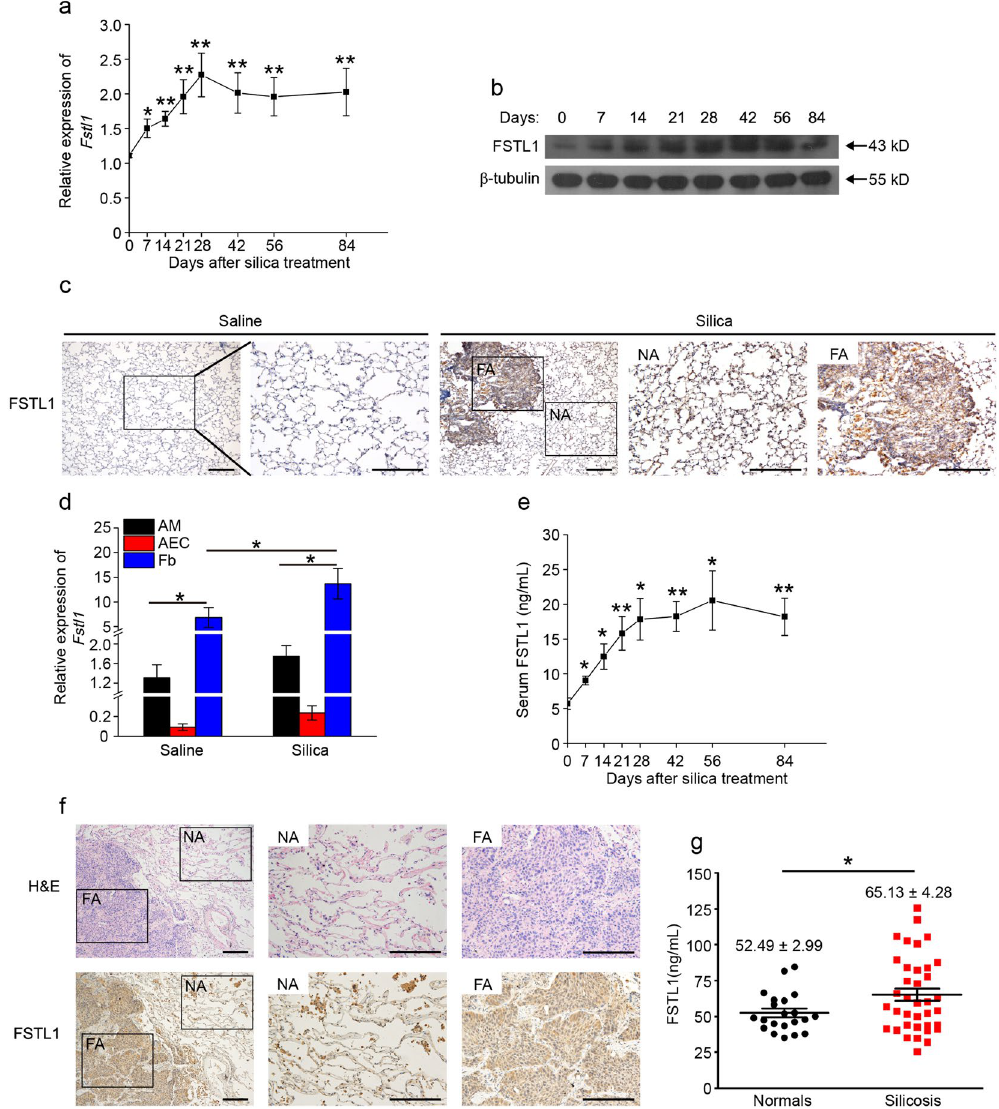
Figure 1. Up-regulation of Fstl1 in silica-injured mice and patients with silicosis. ( a ) Fstl1 mRNA expression in lung tissues of C57BL/6J mice at the different time-point after silica injury was determined by qRT-PCR analysis (n = 6 per group; * P < 0.05; ** P < 0.01 by one-way ANOVA followed by Student’s t test). ( b ) FSTL1 protein in lung tissues of C57BL/6J mice at the different time-point after silica injury was determined by western blot analysis. β -tubulin was used as a loading control. ( c ) Immunohistochemistry (IHC) of FSTL1 in lung sections of C57BL/6J mice 21 days after saline or silica injury. Representative images of the staining are shown. NA stands for normal area, FA stands for fibrotic area; both are shown at higher magnification. (n = 6 per group; scale bars, 200 μ m). ( d ) Fstl1 mRNA expression in primary alveolar macrophages (AMs), alveolar epithelial cells (AECs) and fibroblasts (Fb) at day 21 after saline or silica injury was determined by qRT-PCR analysis (n = 6 per group; * P < 0.05 by one-way ANOVA followed by Student’s t test). ( e ) FSTL1 protein in serum of C57BL/6J mice at the different time-point after silica injury was determined by ELISA analysis (n = 6 per group; * P < 0.05; ** P < 0.01 by one-way ANOVA followed by Student’s t test). ( f ) Representative images of lung fibrotic area of patient with silicosis with H&E staining and immunohistochemical staining for FSTL1 protein (NA stands for normal area, FA stands for fibrotic area; Scale bars, 200 μ m). ( g ) FSTL1 levels in serum of patients with silicosis and normal control individuals were determined by ELISA ( * P < 0.05 by one-way ANOVA followed by Student’s t